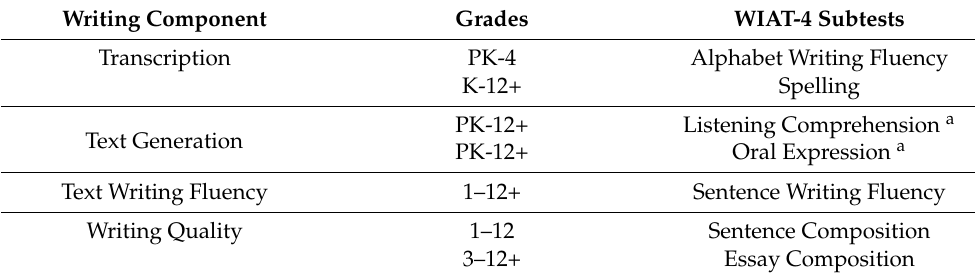
Essay Composition